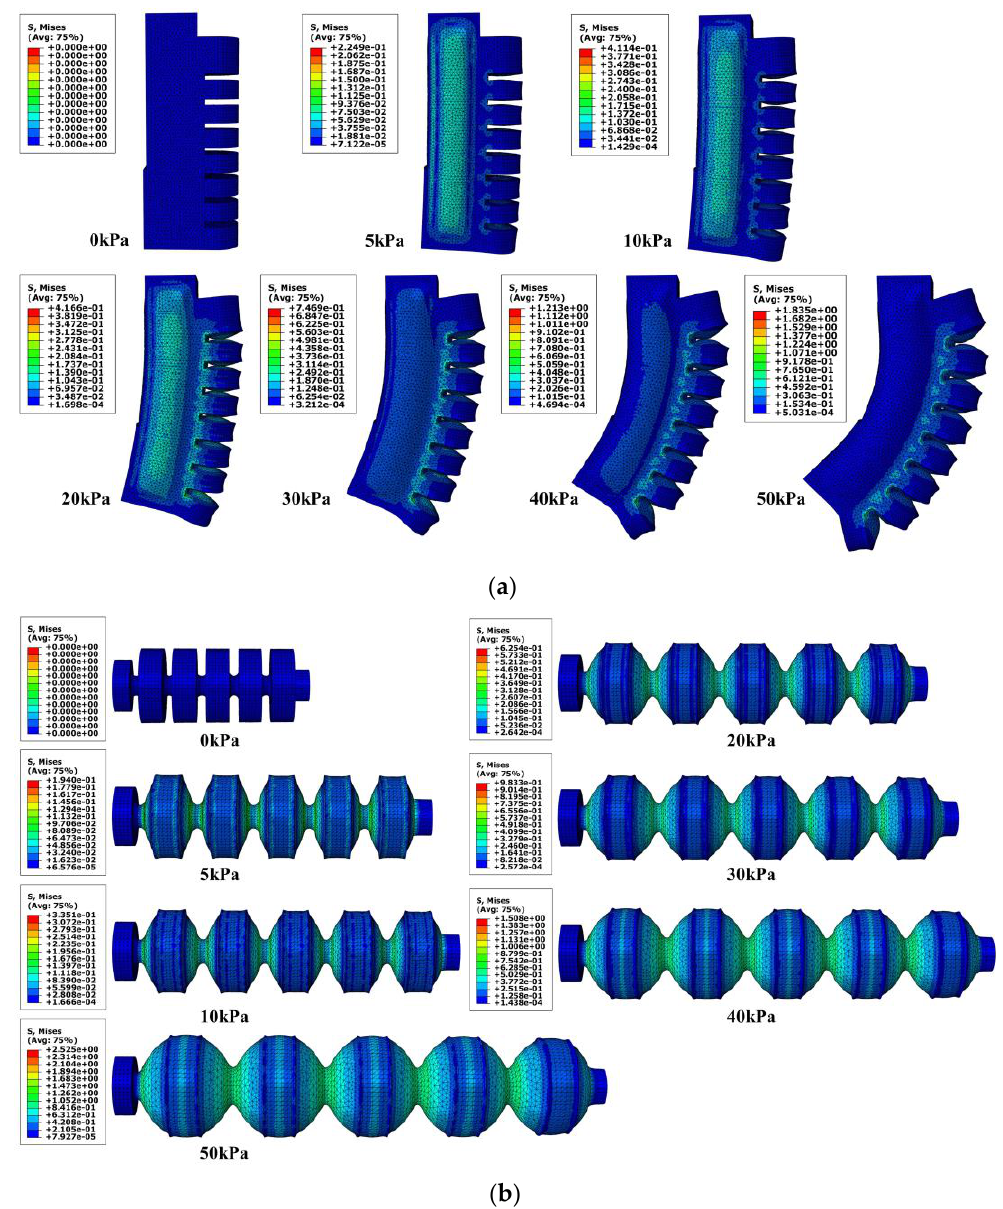
Figure 4. Stress cloud diagram of the actuator under various air pressure conditions in the range of 0~50 kPa. ( a ) Bending actuator ( b ) H − A actuator.